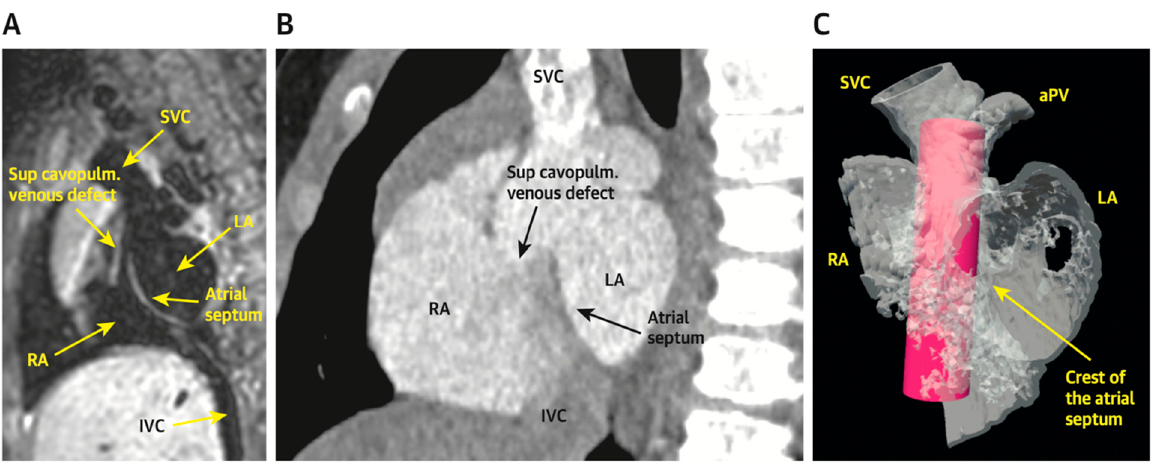
Figure 7. Virtual reality simulation to better understand the relationship of the proposed covered stent to surrounding structures. Both patients in ( A ) (CMR) and ( B ) (CT) were deemed inappropriate candidates for covered stent placement due to SVC angulation to the LA. Imaging from the patient in ( B ) was further confirmed using virtual reality ( C ). The covered stent is represented by the pink cylinder. Revised from ref